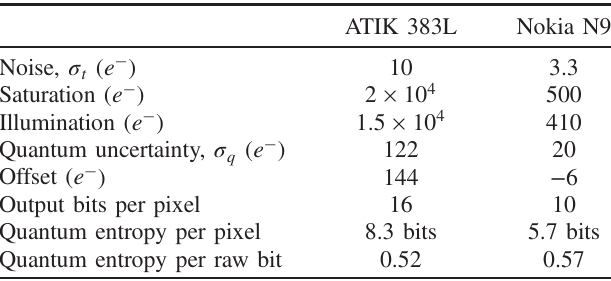
TABLE I. Experimental parameters for the two cameras employed in this experiment.